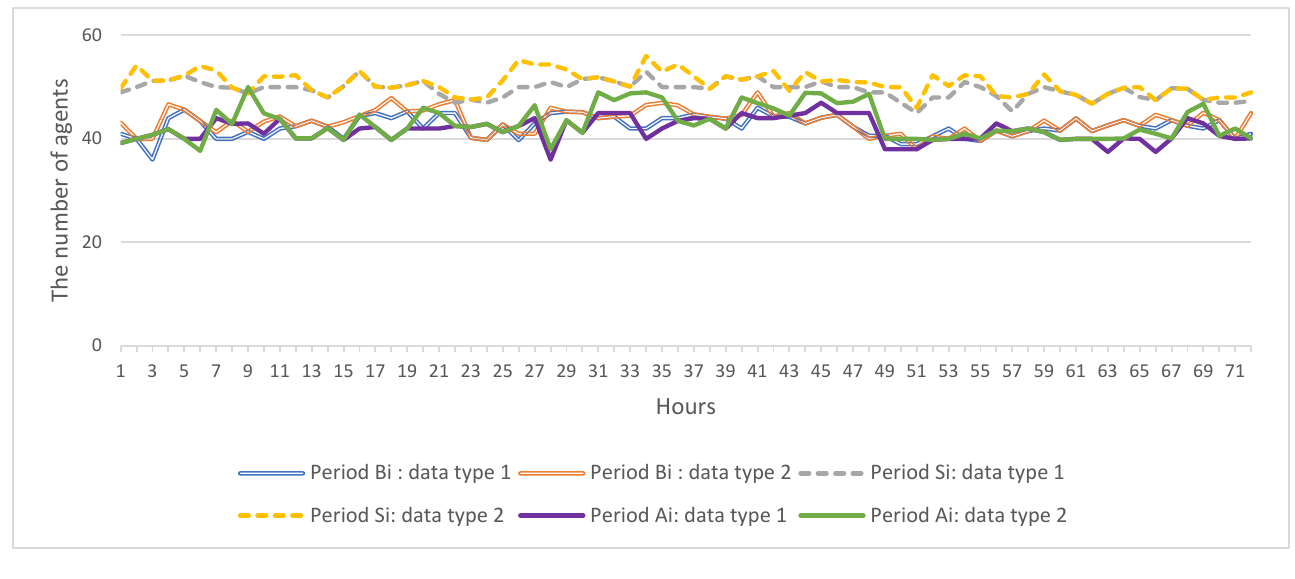
Figure 8. Simulation layout for the number of agents.